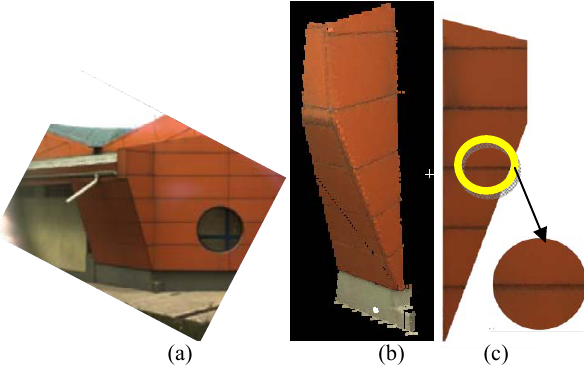
Figure 7. A plan that is part of the secondary façade of the building (a) The image taken with the camera integrated in the scanner system (b) Textured point cloud (c) The surface textured in AutoCad by using the presented algorithm